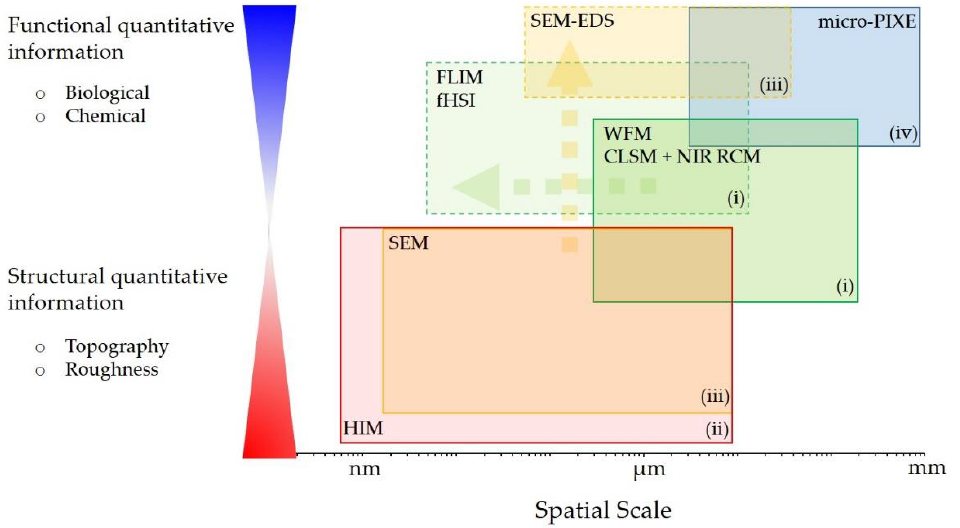
Figure 1. The experimental workflow phase diagram comprising complementary imaging and spectroscopy techniques ( i – iv ) to cover wide spatial range and to gain both functional and structural information on the investigated system. For more detailed instrumentation see Figures S1–S3 in the Supplementary Materials.